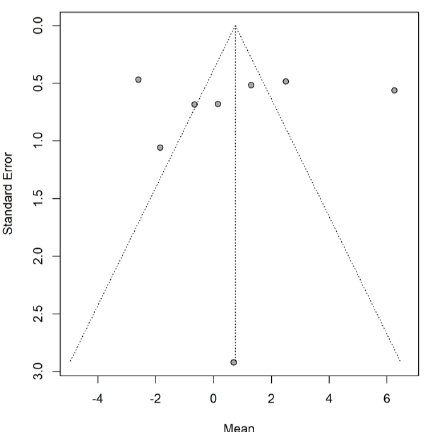
Figure 3. The funnel plot of studies that provided sufficient data on weight